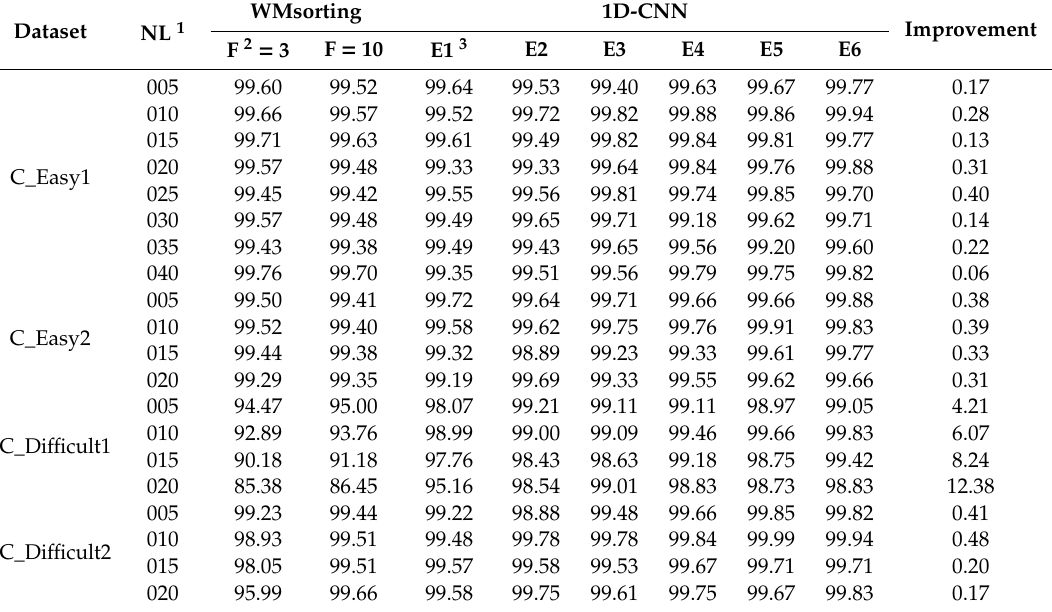
Table 1. Comparison of classification accuracy on simulated database (using “WMsorting”). 1D, one-dimensional.